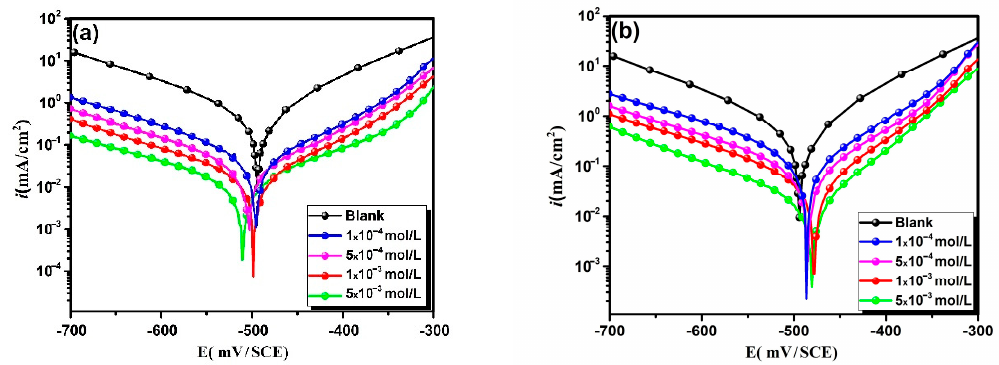
Figure 3. PDP curves of mild steel corrosion in the absence and presence of various concentrations of ( a ) Q1 and ( b ) Q2at 303 K. Table 1. Polarization parameters and inhibition efficiency of MS in 1 mol/L HCl solution without and with different concentrations of Q1 and Q2 at 303 K.